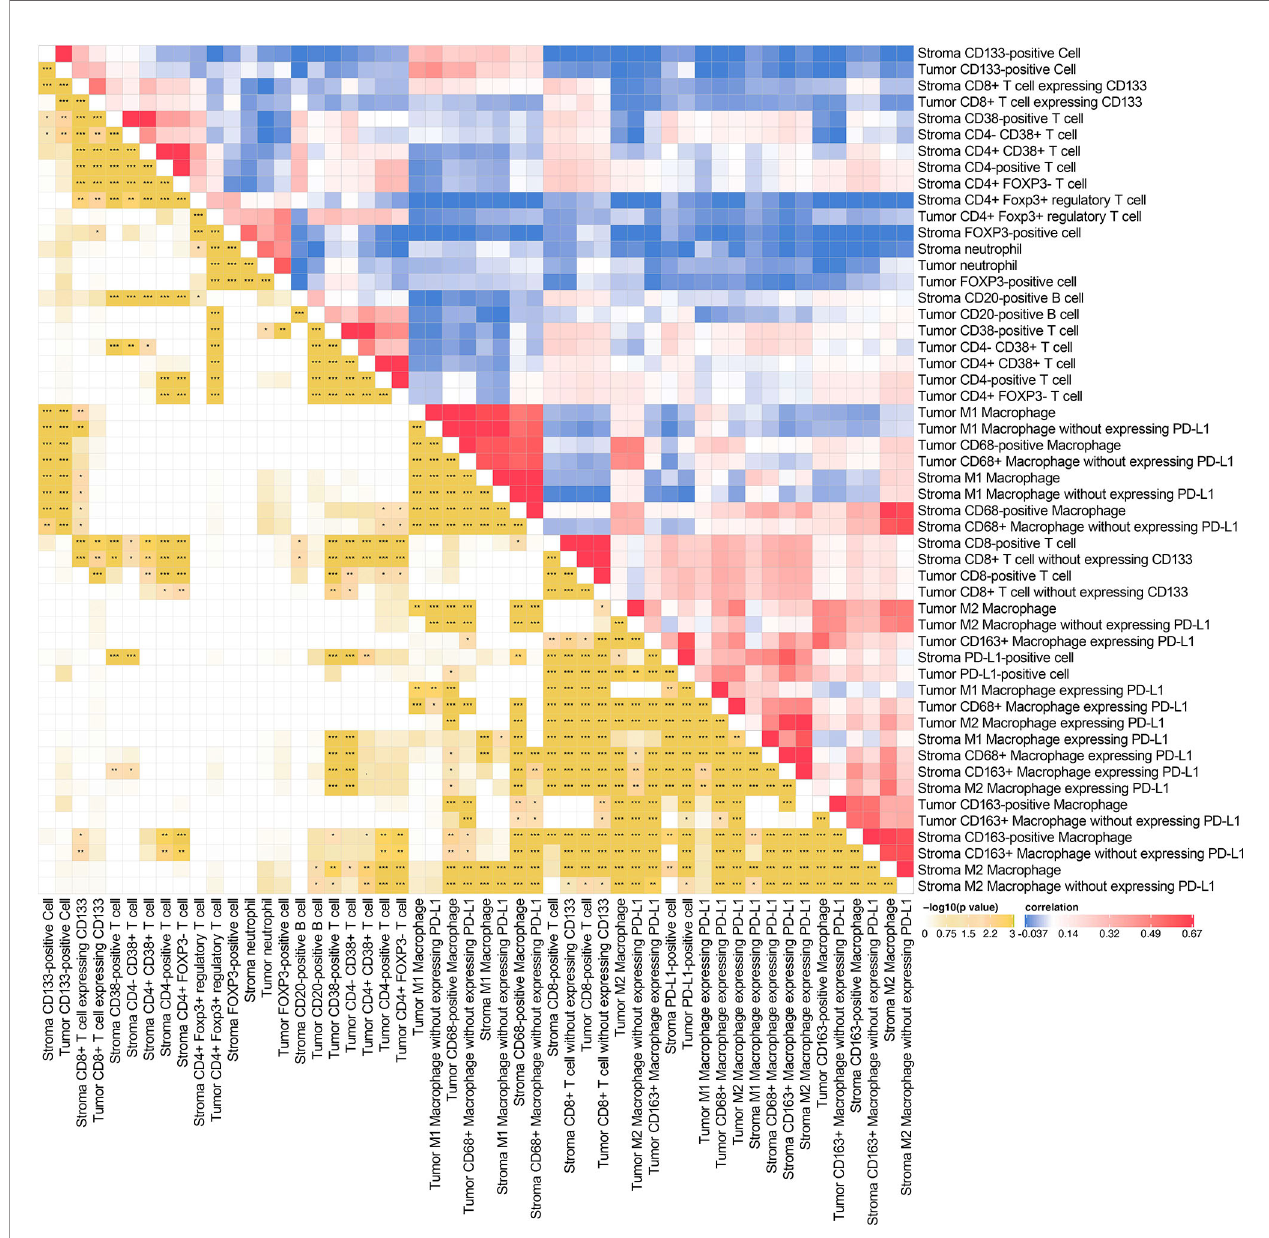
FIGURE 2 | Spearman ’ s rank correlation matrix (right half) and corresponding p -value (left half) among various intratumoral and intrastromal immune cell types. * P < 0.05, ** P < 0.01, *** P <